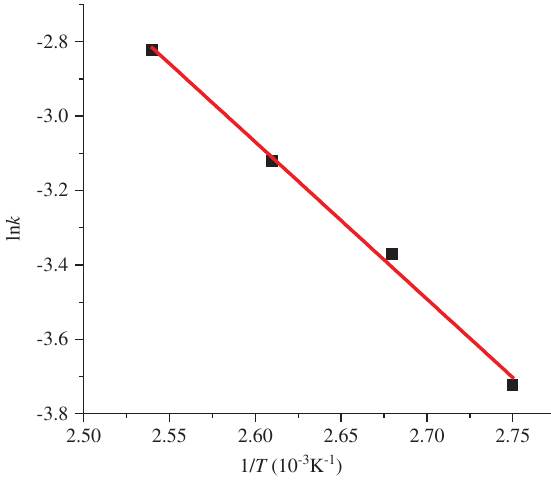
Figure 4: Arrhenius plot of ln k versus 1/